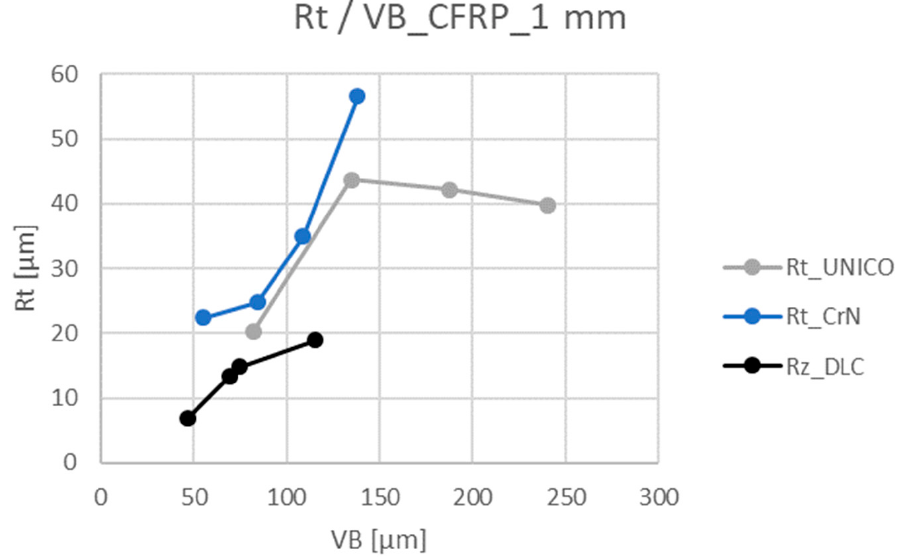
Figure 21. Dependence of the surface roughness parameter R t on wear, laminate thickness 1 mm. R t —total height of profile. VB—flank wear.